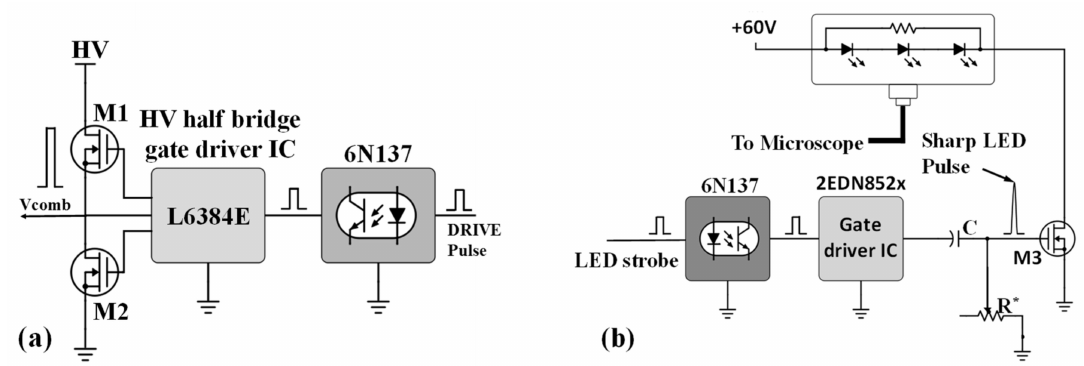
Figure 6. ( a ) Schematic of the half bridge gate driver configuration of high voltage MEMS driver ckt. and ( b ) schematic of the high-speed LED switching ckt. using an ultrafast gate driver integrated circuit (IC) with an R*C differentiator ckt. for producing sharp LED